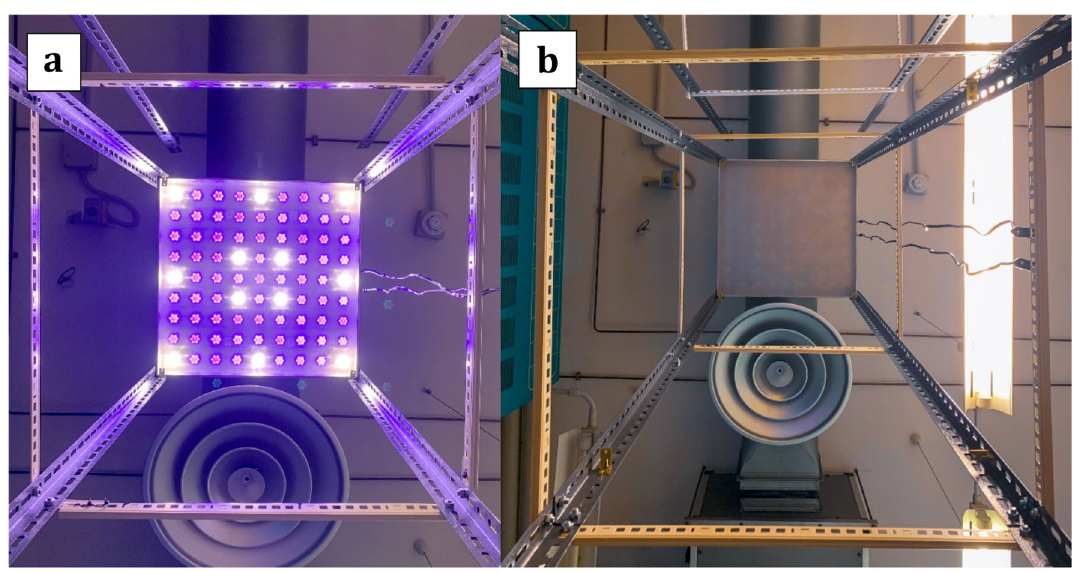
Figure 2. VBL405 ceiling lamp. View from below of the ceiling lamp turned ON ( a ) and OFF ( b polystyrene cover on the plate. The attenuation of light through a transparent medium follows an exponential relationship, known as Lambert’s law, so the energy doses administered were measured considering the cover attenuation effect of about 7%. The experiment was repeated in triplicate for each bacterial strain. In addition, for 5 separate days 2 m 3 of air from the sealed room were aspirated with Sas Microflow α (Aquaria, Lacchiarella, Italy) samplers, at a speed of 120 L/min. The aspirated air impacted on the surface of 60 mm Ø